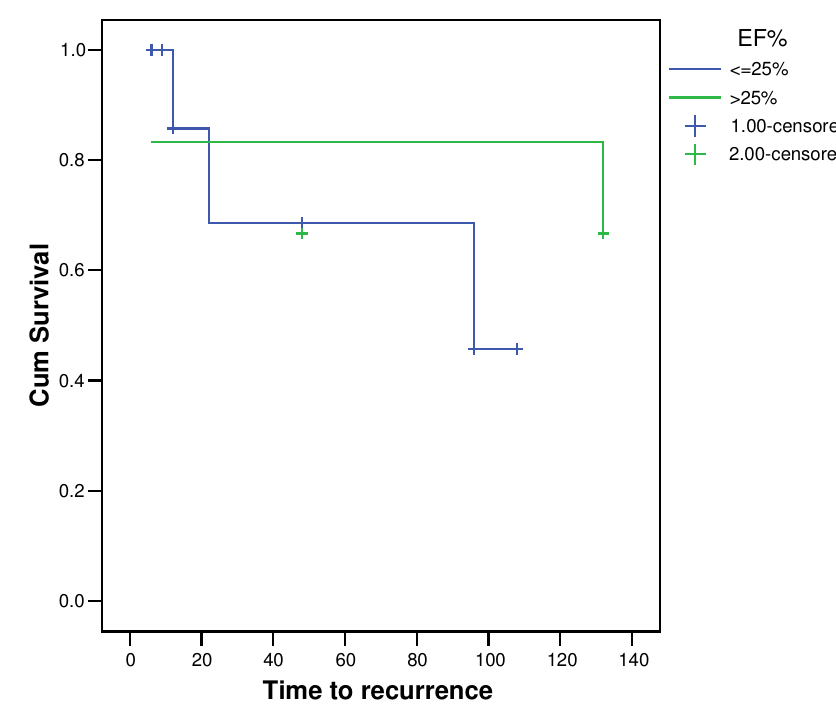
FIGURE 3. Freedom from death or transplantation for patients with pure DCM with EF ≤ 25% (GLPSS < –7.6%) and EF > 25%. There was high incidence of recurrence of major cardiovascular events among children with EF < 25% and low two-dimensional strain values.